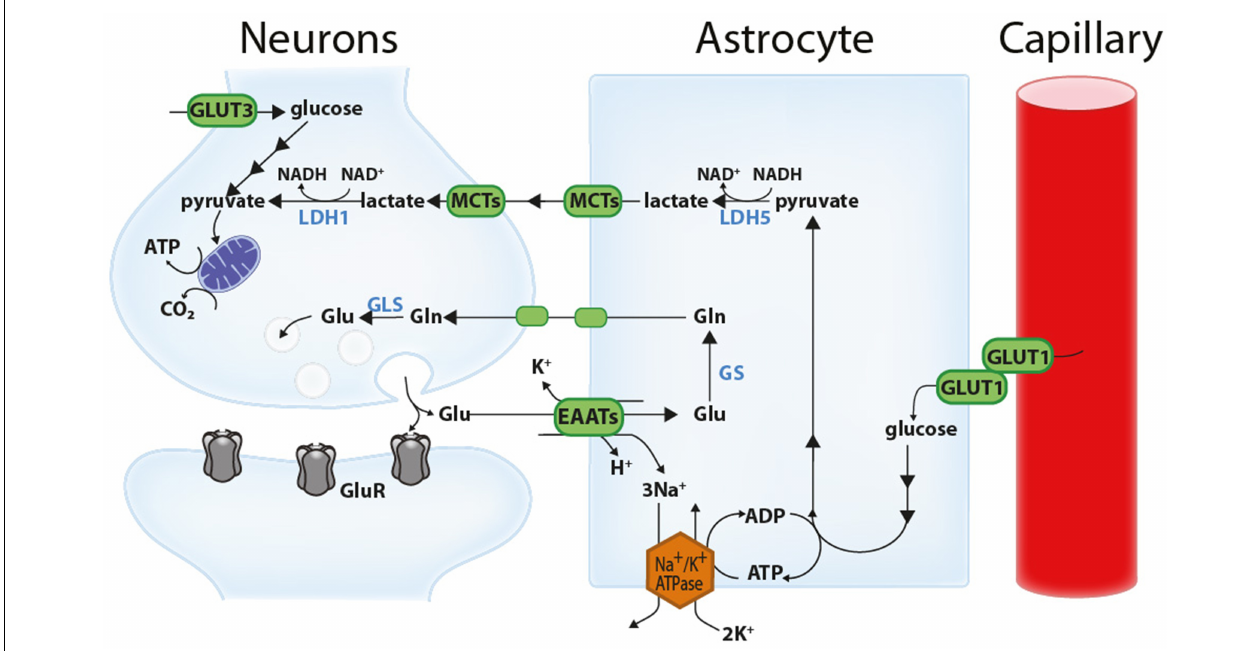
FIGURE 1 | Schematic representation of the astrocyte-neuron lactate shuttle (ANLS). Glutamate (Glu) released at the synapse activates glutamatergic receptors (GluR) and is associated with important energy expenditures in neuronal compartments. A large proportion of the glutamate released at the synapse is taken up by astrocytes via excitatory amino acid transporters (EAATs, more specifically GLT-1 and GLAST) together with 3 Na + ions. This Na + is extruded by the action of the Na + /K + ATPase, consuming ATP. This triggers non oxidative glucose utilization in astrocytes and glucose uptake from the circulation through the glucose transporter GLUT1 expressed by both capillary endothelial cells and astrocytes. Glycolytically-derived pyruvate is converted to lactate by lactate